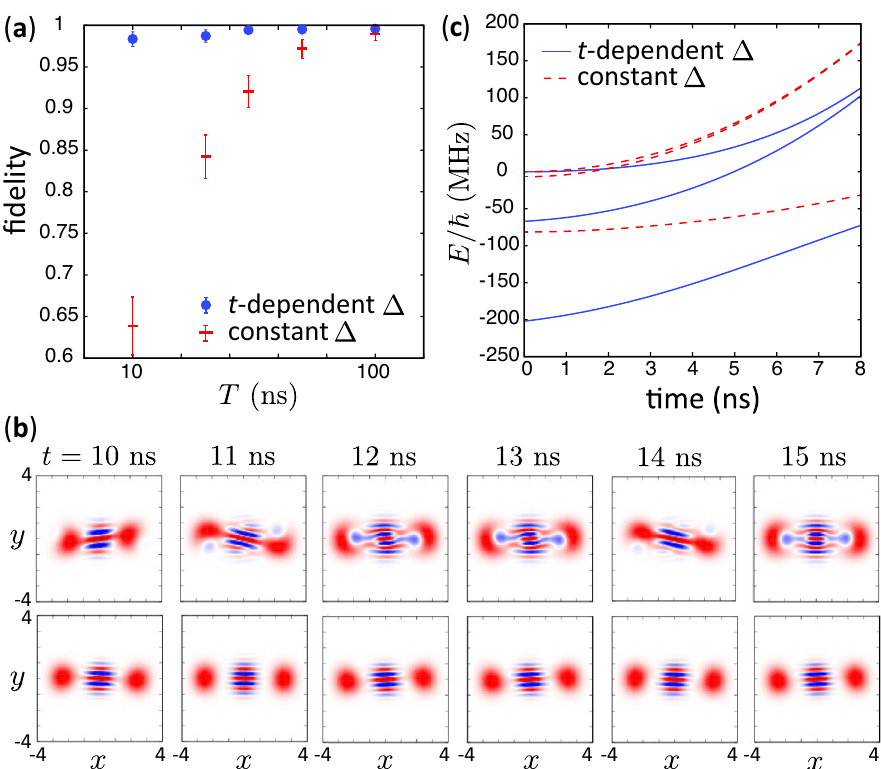
Figure 4. ( a ) Fidelity of the creation of a cat state as a function of T with the time-dependent detuning in Eq. (8) (blue circles) and the constant detuning of �/ 2 π account in the both dynamics. The error bars represent the standard deviation which is calculated using the data for t > T . The used parameters are � 0 / 2 π 68 MHz. ( b ) Wigner functions for t χ/ 2 π = the time-dependent (lower figures) detunings. The other parameters are the same as ( a ). ( c ) The three highest eigenenergies of instantaneous H RWA in Eq. (5) for the constant and the time-dependent detuning for T ns. The other parameters are the same as ( a